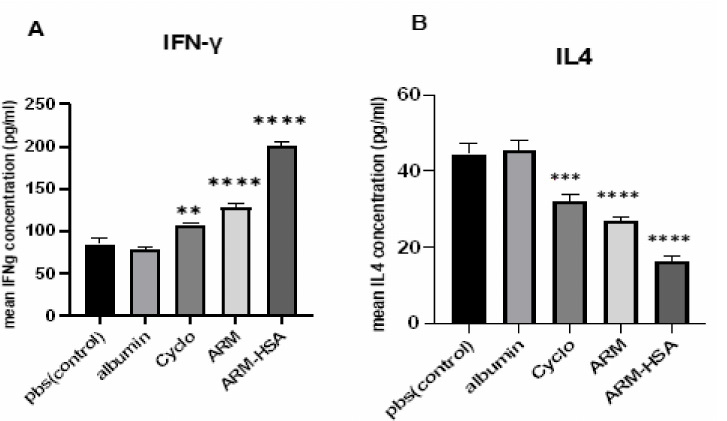
Figure 9. Results of IFN γ ( A ) and IL4 ( B ) secretion in five groups receiving PBS, albumin, cyclophos- phamide, artemether and nanoparticles. Asterisks show the statistically significant difference between various groups. (** p < 0.01, *** p < 0.001, and **** p < 0.0001). The significance of data from each were compared to the control